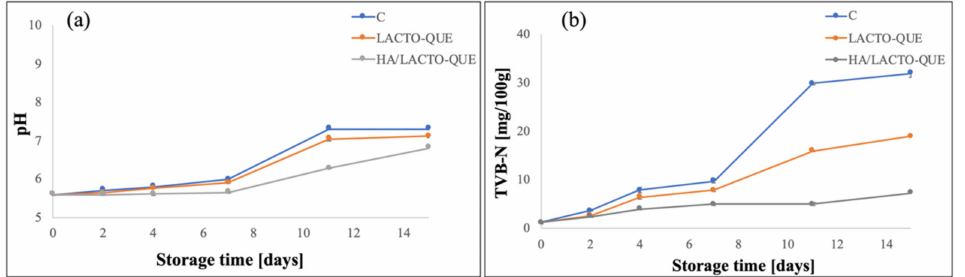
Figure 5. Effects of alginate-based coatings on pH ( a ) and TVB-N ( b ) of pork meat samples during the storage